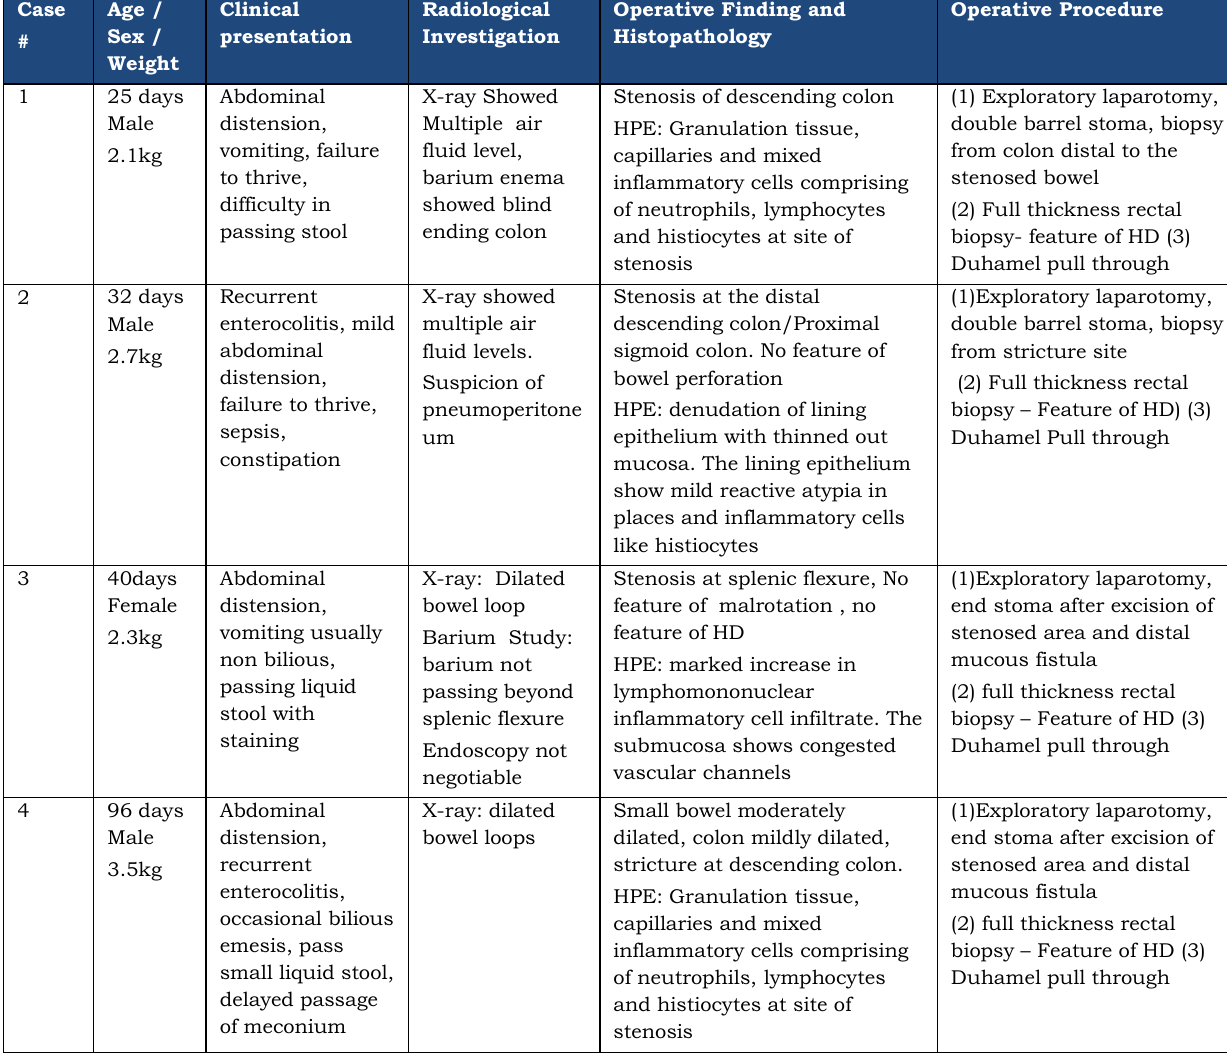
Table 1: Showing the summary of the